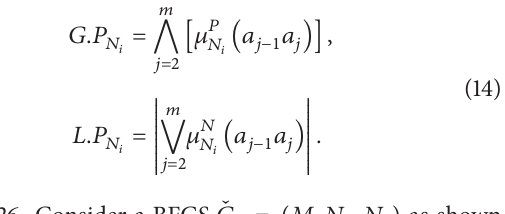
̌𝐾 = (𝑀 , 𝑁 , 𝑁 ) 𝑏 1 11 12